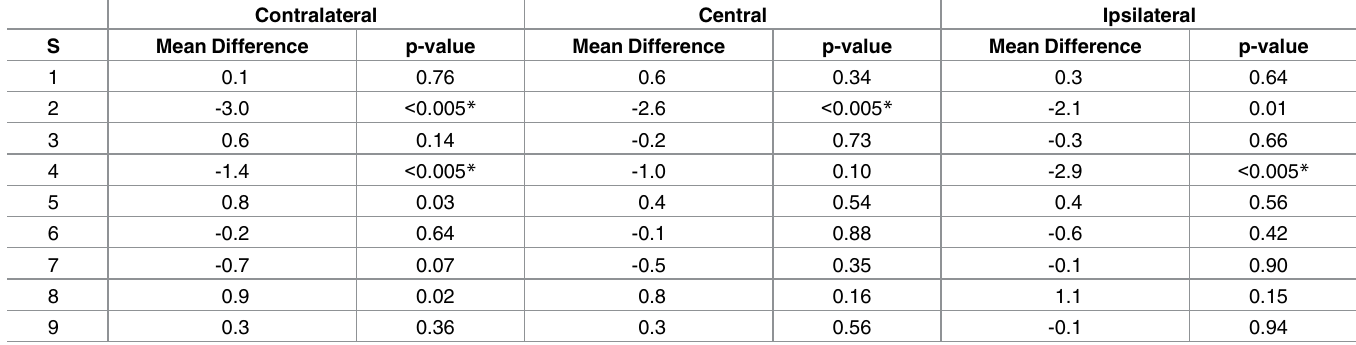
Table 2. Pairwise comparisons of absolute errors between each subject and the control group in the 3 directions. Mean differences are evaluatedas Control-S. Significant differences are marked with an